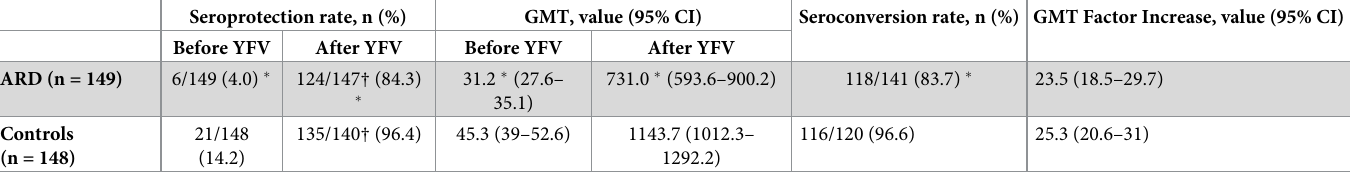
Table 3. Immunogenicity of fractional-dose yellow fever vaccine (YFV) in autoimmune rheumatic diseases patients and controls. Seroprotection rate, n (%)